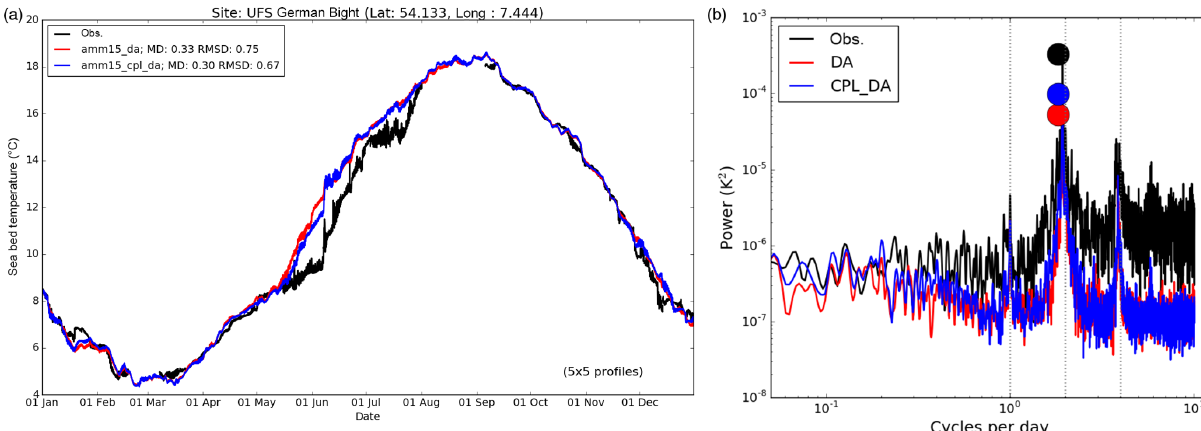
Figure 7. (a) Time series of simulated seabed temperature (SBT) during 2017 from DA and CPL_DA simulations and observed values in the German Bight (buoy UFSDB). Summary MD and RMSD statistics are listed for each run. (b) Computed power spectra for observed, DA and CPL_DA simulated SBT. Filled circles highlight the amplitude of the peak power for each time series. Vertical dotted lines mark diurnal, semi-diurnal, and quarter-diurnal frequencies. Table 4. Summary statistics comparing DA and CPL_DA results for sea surface temperature (SST) and seabed temperature (SBT) with co-located observations during 2017 at sites in the German Bight (starred symbols in Fig. 3a). Mean difference (MD) (Model minus Obs.) RMSD FINO1 FINO3 NsbII TWEMS UFSDB FINO1 FINO3 NsbII TWEMS UFSDB SST